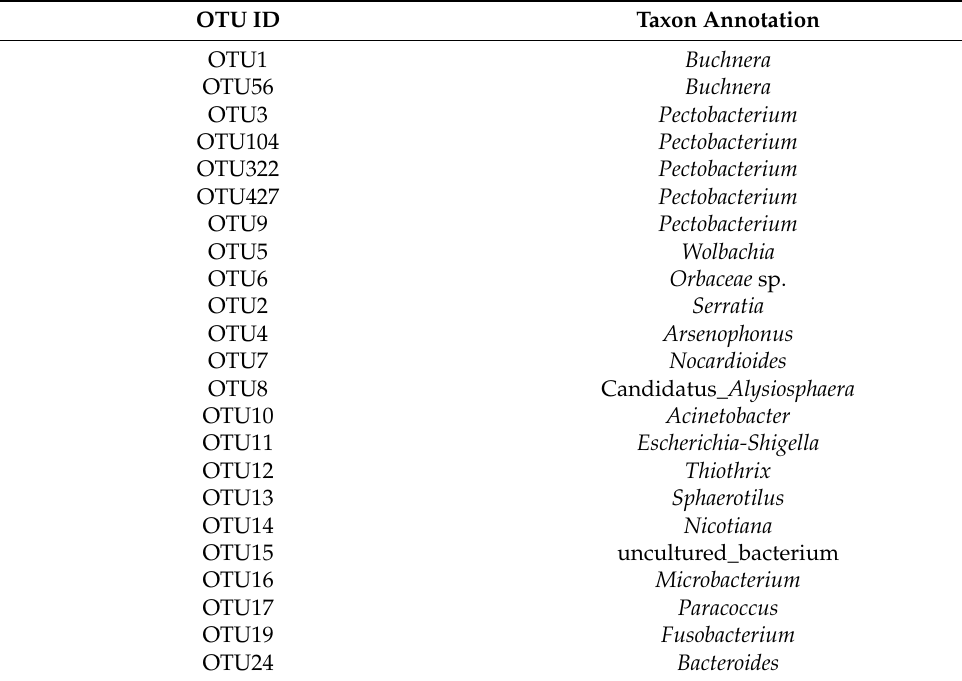
Table 2. Taxonomic assignment of bacterial OTUs in Pseudoregma bambucicola.